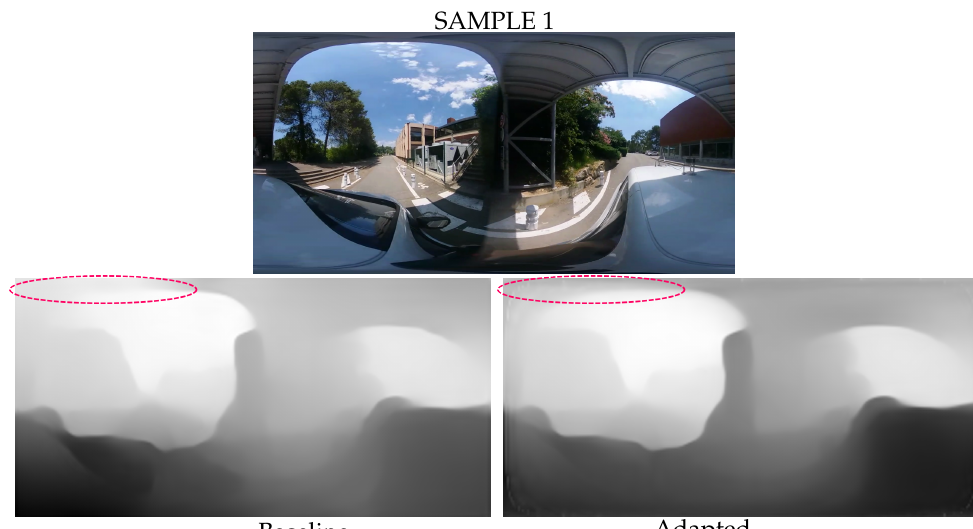
Figure 7. Urban driving examples. The adapted network better estimated depth in the polar regions of the equirectangular images. A red circle at the top left of the image highlights the area with the most visible